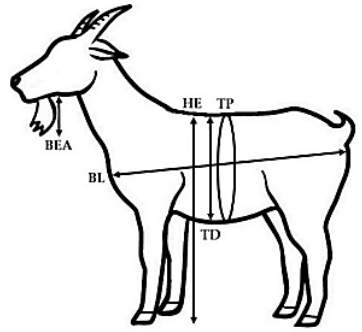
Figure 2. Morphological variables evaluated and their body reference points: TP: thoracic perimeter, cm; TD: thoracic diameter cm; BL: body length, cm; HW: height at withers, cm; BEA: length of beard, cm, in crossbred (Alpine-Saanen-Nubian x Criollo; n = 70) dairy goats managed under intensive, stall fed conditions in Northern Mexico (March, 25° North). Data concerning the linear and morphometric measures were collected and elaborated in all goats (n = 70); two morphometric indices were calculated: the compactness index COM = [live weight/height at withers] × 100, and the anamorphosis index ANA = (thoracic perimeter) 2 / height at withers).